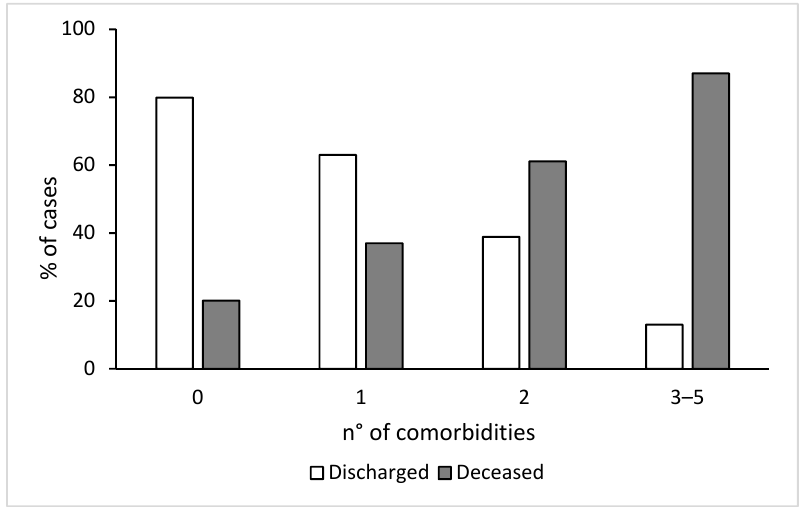
Figure 1. Pattern of comorbidities related to metabolic impairment in discharged vs. deceased patients. Co-morbidities include diabetes, dyslipidemia, heart disease, hypertension and